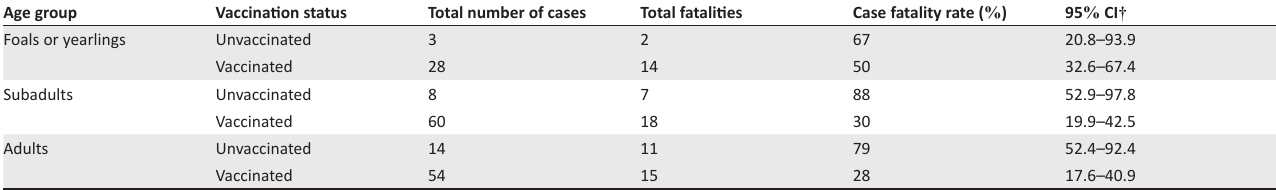
TABLE 2: Case fatality rates for African horse sickness in vaccinated and unvaccinated horses according to age group. Age group Vaccination status